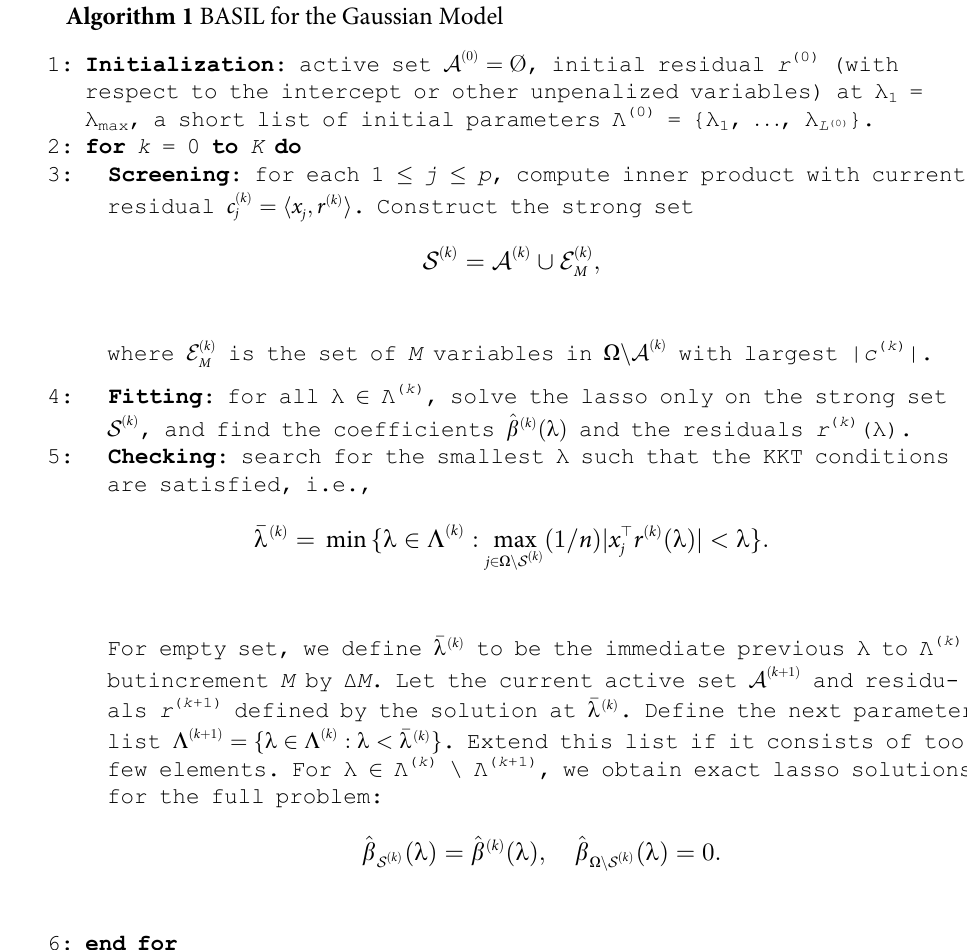
Algorithm 1 BASIL for the Gaussian